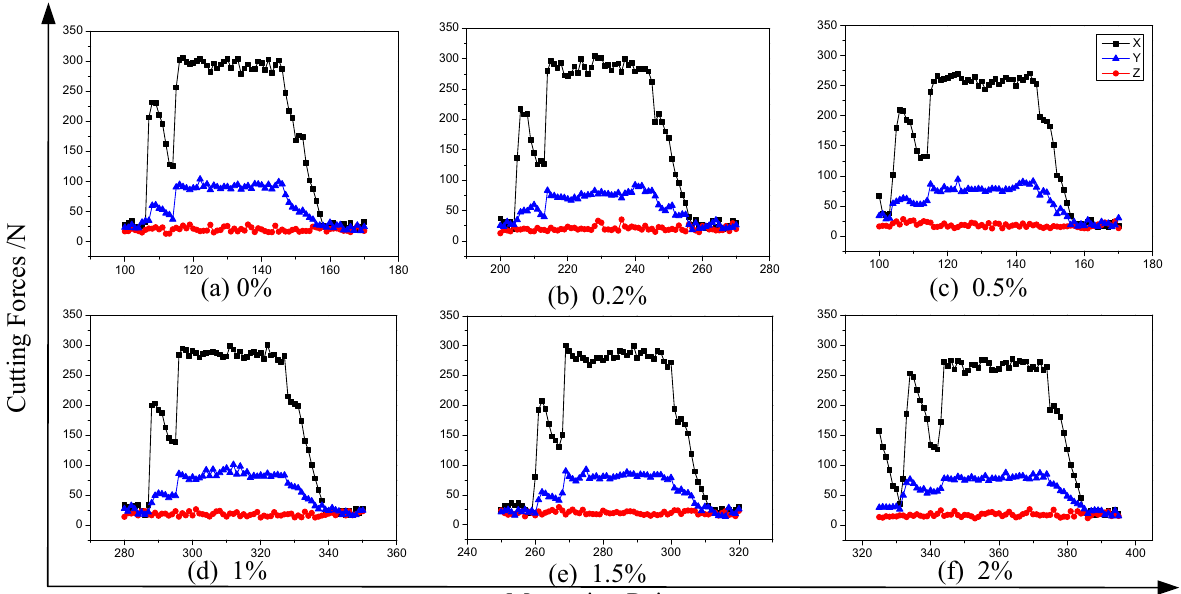
Figure 2 Trend of cutting force under six different concentrations of nanofluids